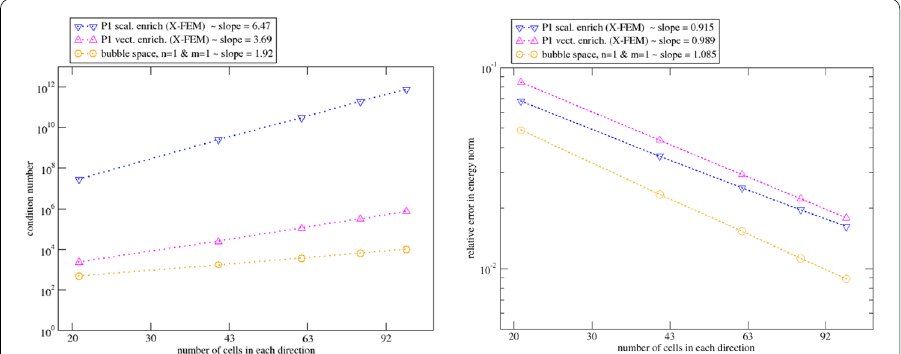
Fig. 34 Convergence and conditioning analysis with linear elements for a horizontal crack